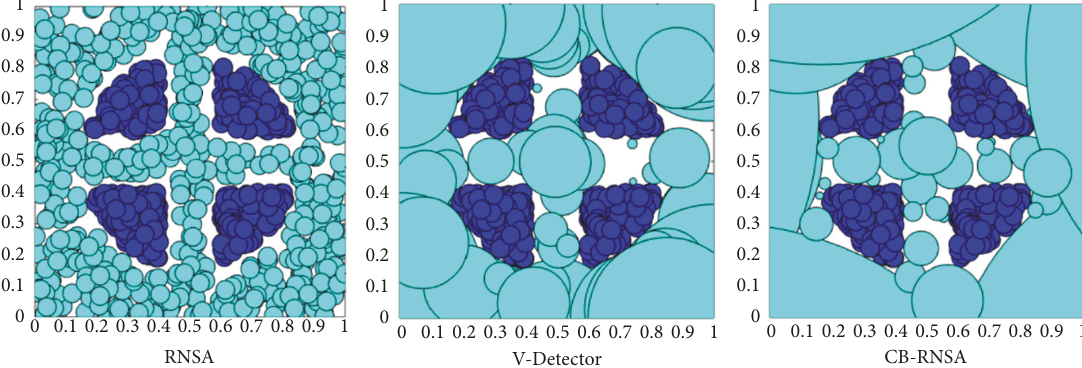
Figure 14: Comparisons of RNSA, V-Detector,and CB-RNSA in Intersection(to achievethe expected coverage rate90%, RNSA, V-Detector, and CB-RNSA need 590, 85, and 40 mature detectors, respectively, where the training set size is 500, the self radius is 0.03, and the detector radius of RNSA is 0.03).